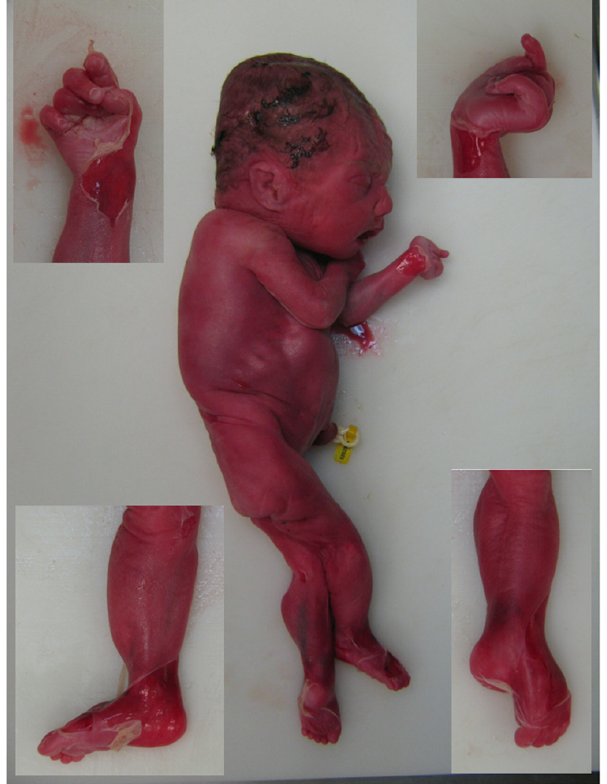
Figure 2. Lateral view of the fetus. Lateral view of the fetus shows skin slippage due to maceration. Both hands show medially overlapping fingers ( upper insets ) and left pes equinus ( lower insets ).